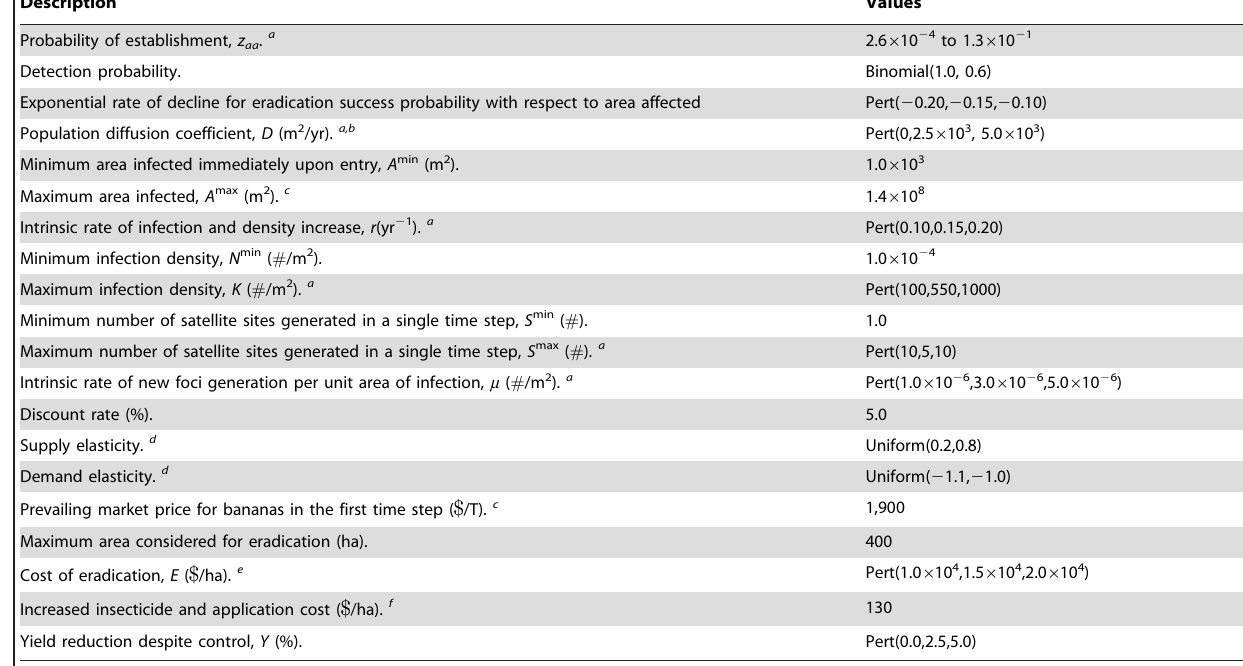
Table 1. Model parameters.